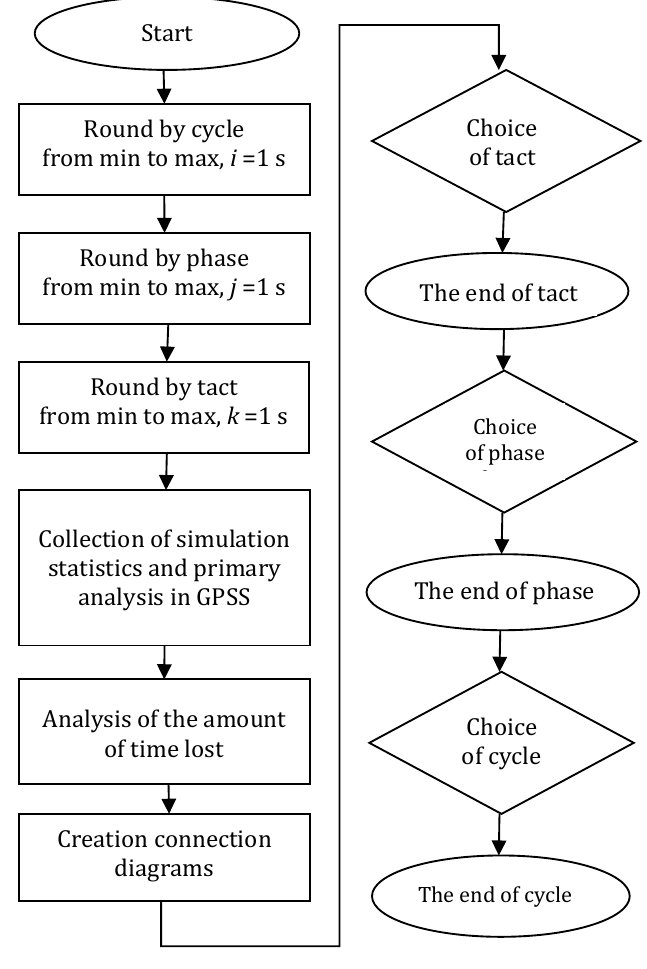
Figure 3: Algorithm for optimizing the traffic light